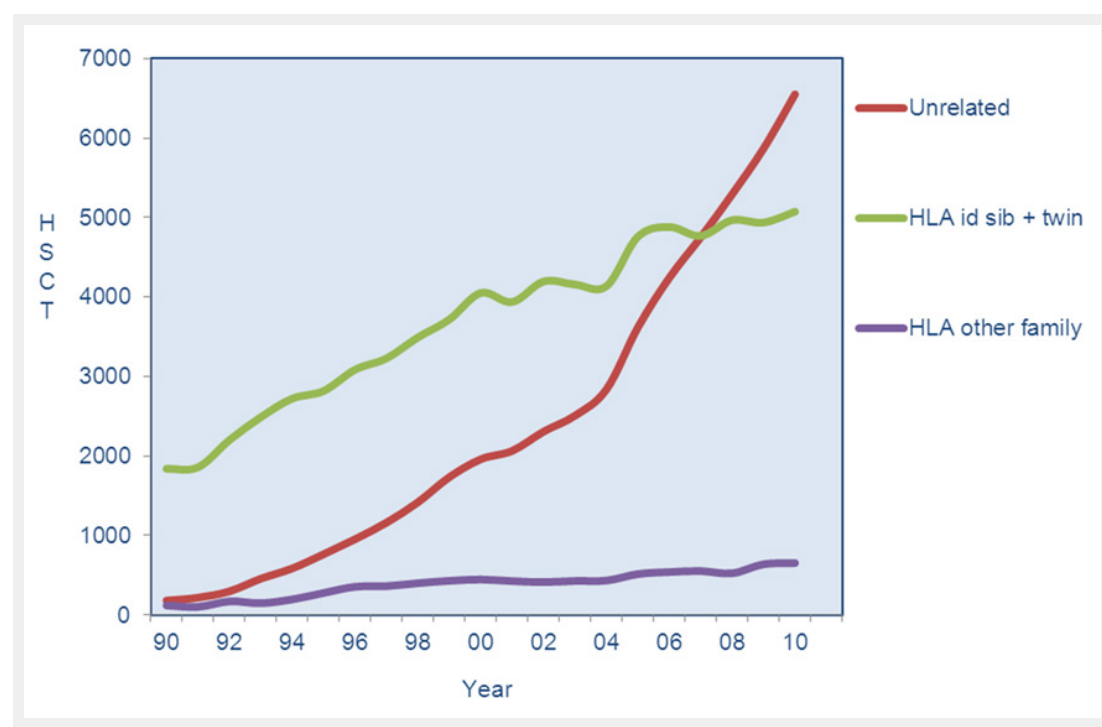
Figure 3 Use of different donor types for allogeneic HSCT in Europe 1990–2010 (reprinted from: Passweg JR, Baldomero H, Gratwohl A, Bregni M, Cesaro S, Dreger P, et al.; for the European Group for Blood and Marrow Transplantation (EBMT). The EBMT activity survey: 1990–2010. Bone Marrow Transplant. 2012;47(7):906-23 [3]).